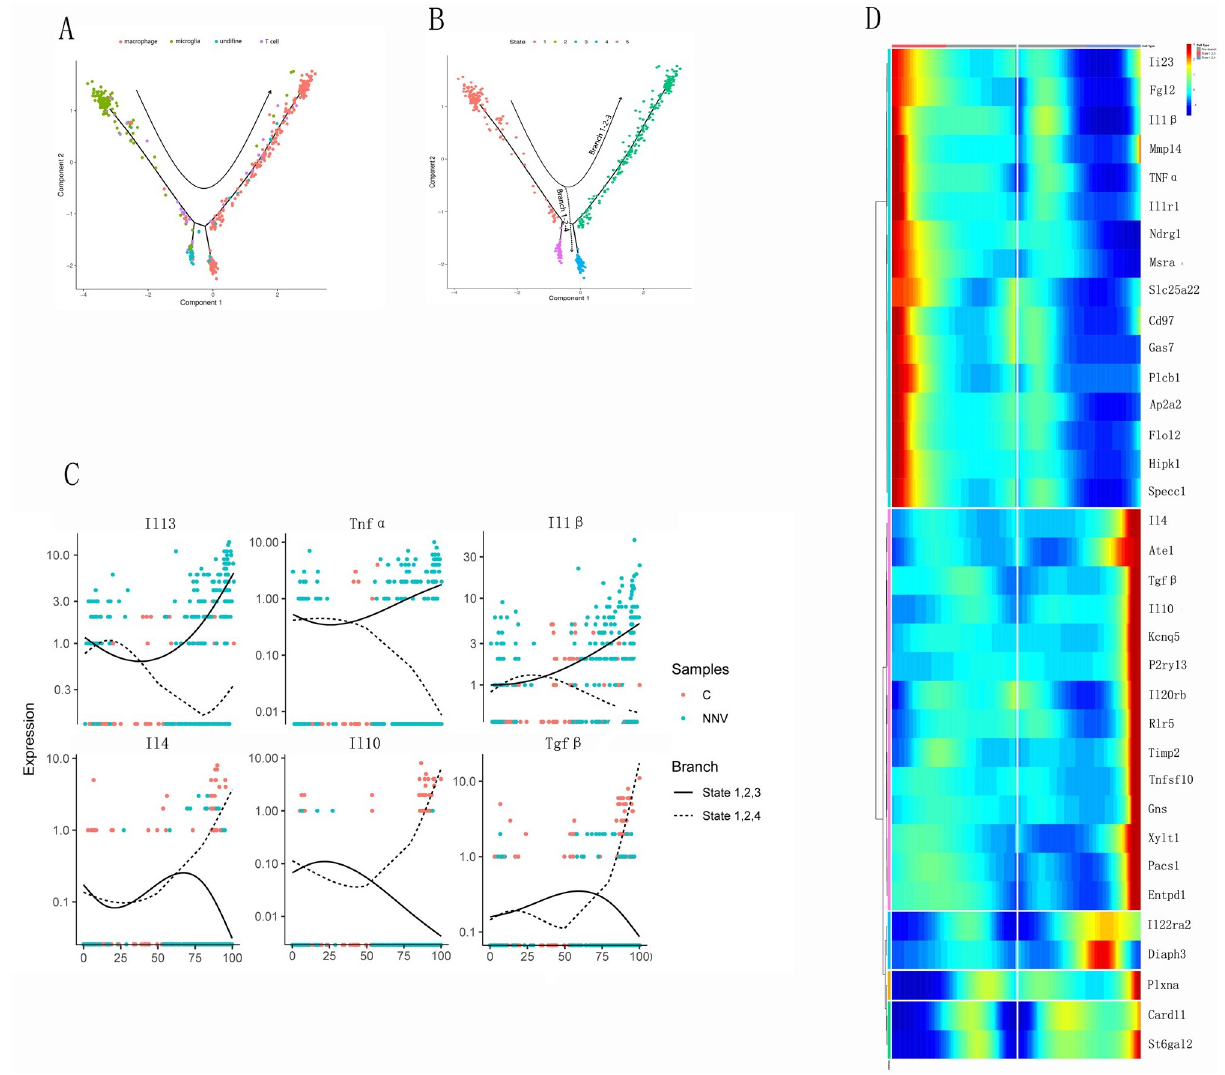
Fig 6. Transcriptional dynamics during development of macrophages. (A) Pseudotemporal ordering of different clusters based on their gene expression profiles. Arrows indicate the direction of differentiation. (B) Pseudotemporal ordering of differentiated states in the macrophage cells. The dashed line represents branch 1-2-3; the solid line represents branch 1-2-4. Cells are colored by state. (C) Expression of M1-type macrophage and M2-type macrophage marker genes along the two primary branches ordered in pseudotime. Solid lines represent expression in branch 1-2-3 (M1-type macrophages), and dashed lines represent expression in branch 1-2-4 (M2-type macrophages). (D) Branched heat map showing macrophages with highly significant branch-specific expression patterns in pseudotime. The root of the tree is in the middle of the plot, and expression from the earliest to the M1-type macrophages progresses to the left, whereas the progression of M2-type macrophages progresses to the right of the